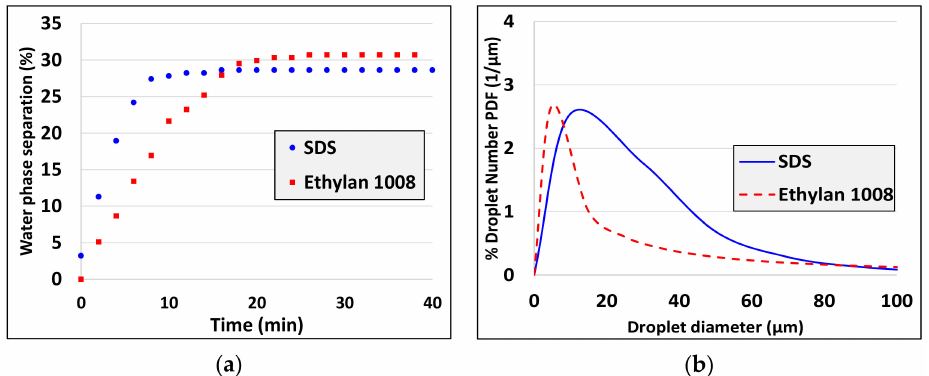
Figure 10. E ff ect of surfactant type on ( a ) water phase separation and ( b ) droplet size distribution of emulsions (C SDS = 1 CMC, C Ethylan 1008 = 1 CMC, ϕ = 0.2, t n = 2 min and f = 10 Hz; Piston 1, SDS: